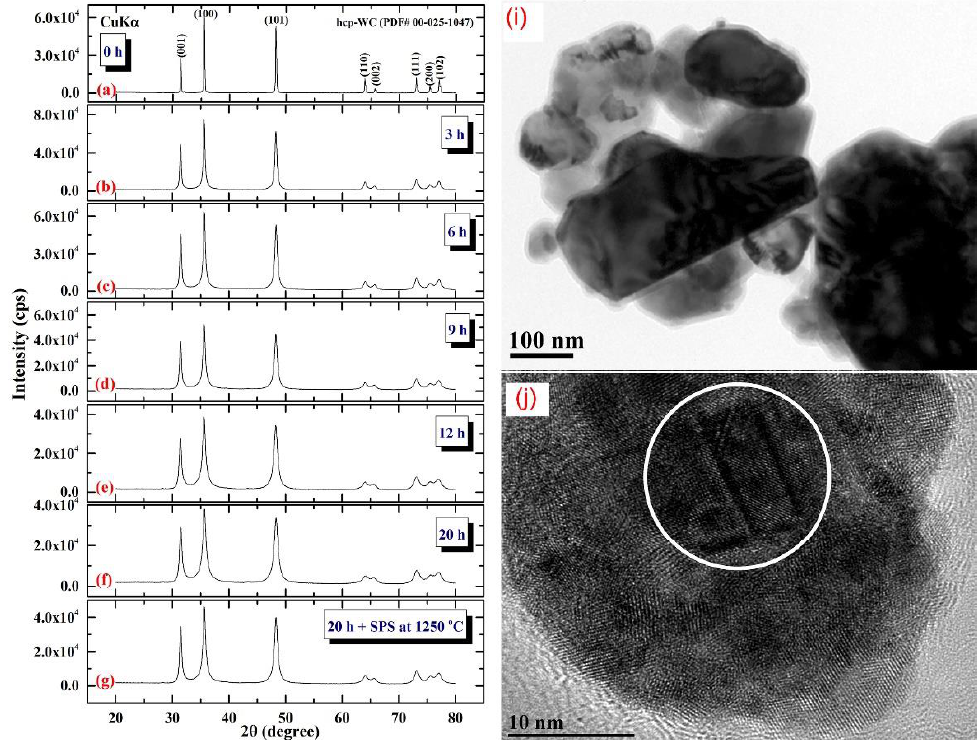
Figure 11. XRD patterns of ball milled WC powders treated for ( a ) 0, ( b ) 3, ( c ), 6 h, ( d ), 9 h, ( e ), 12, and ( f ), 20 h of milling. The powders produced after 20 h of milling and subsequently consolidated into bulk buttons at 1250 °C using the SPS method are depicted in the XRD ( g ). The bright field images (BFIs) of mechanically milled hcp-of-milling WC powders produced after 1 h and 3 h of high energy ball milling are shown in ( i ) and ( j ).